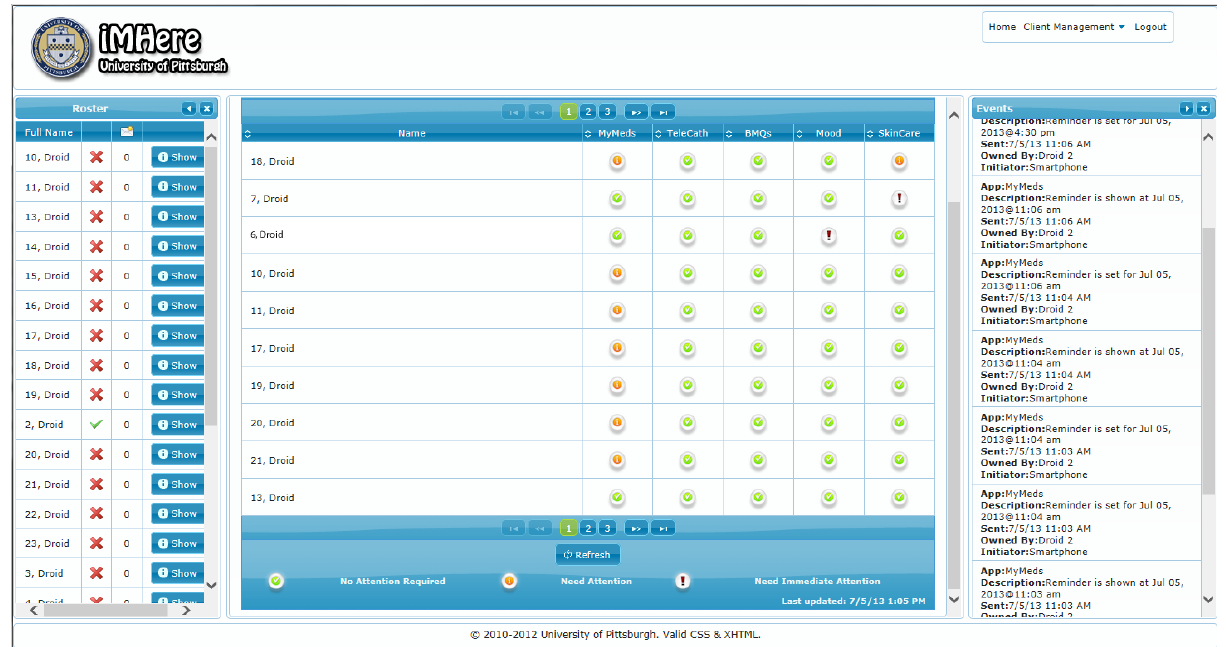
Figure 7. Clinician portal: roster table displays a list of registered patients and their connection status. Dashboard displays priority flags for each patient and